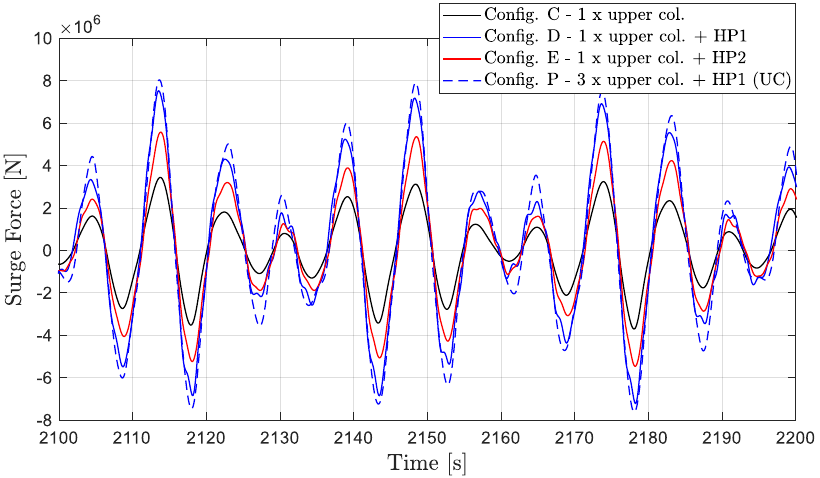
Figure 13. Measured wave surge force on the upstream column (UC) in bichromatic wave B1, showing impact of additional model components and columns on the hydrodynamic loading. The force time histories have been low − pass filtered with a cutoff frequency of 0.6 Hz (full scale) to remove the effect of structural vibration.